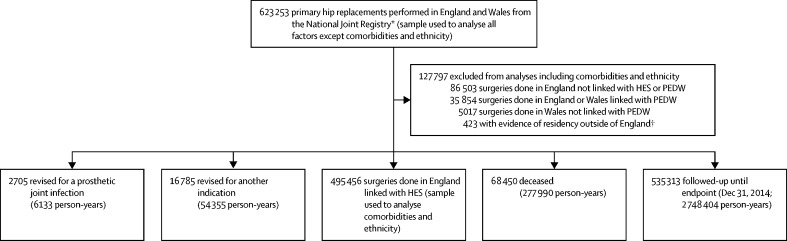
Description of the sampleHES=Hospital Episode Statistics for England. PEDW=Patient Episode Database for Wales. *Only data for England and Wales were considered; data collection for Northern Ireland started Feb 2, 2013, and primary revision procedures could not be considered due to their limited number and restricted follow-up. Data collection for the Isle of Man started on July 1, 2015, after the endpoint of this study and were not considered. †As recorded in HES for the 5 years preceding the primary hip replacement.